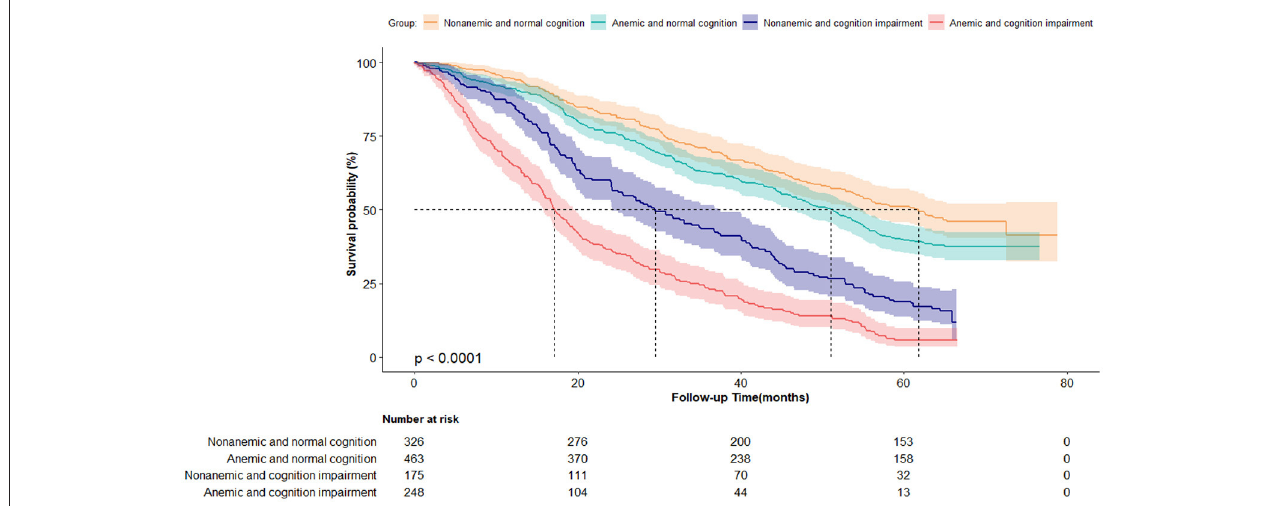
FIGURE 3 | Kaplan-Meier survival curves by the 4-level joint anemia/cognition impairment groups in oldest-old adults ( N = 1,212). Log-rank P < 0.0001.